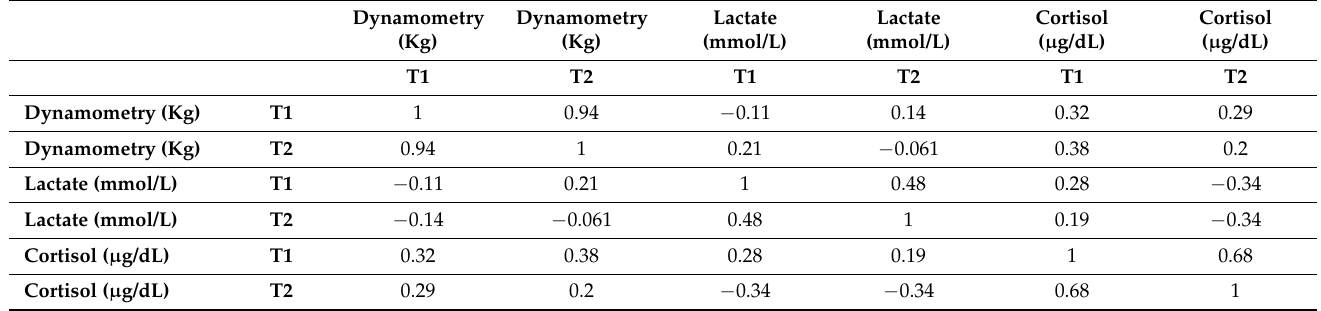
Table 6. Correlation chart in women comparing different